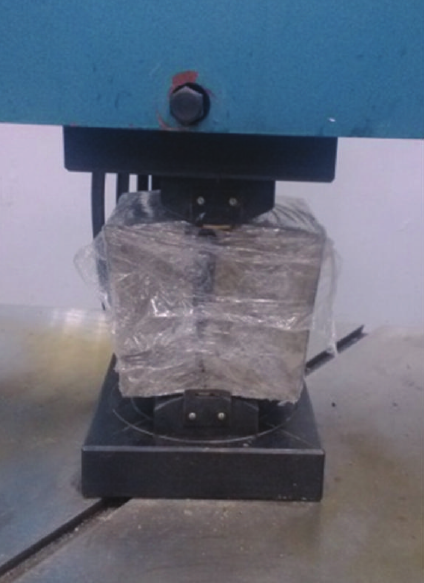
Figure 5: Splitting tensile